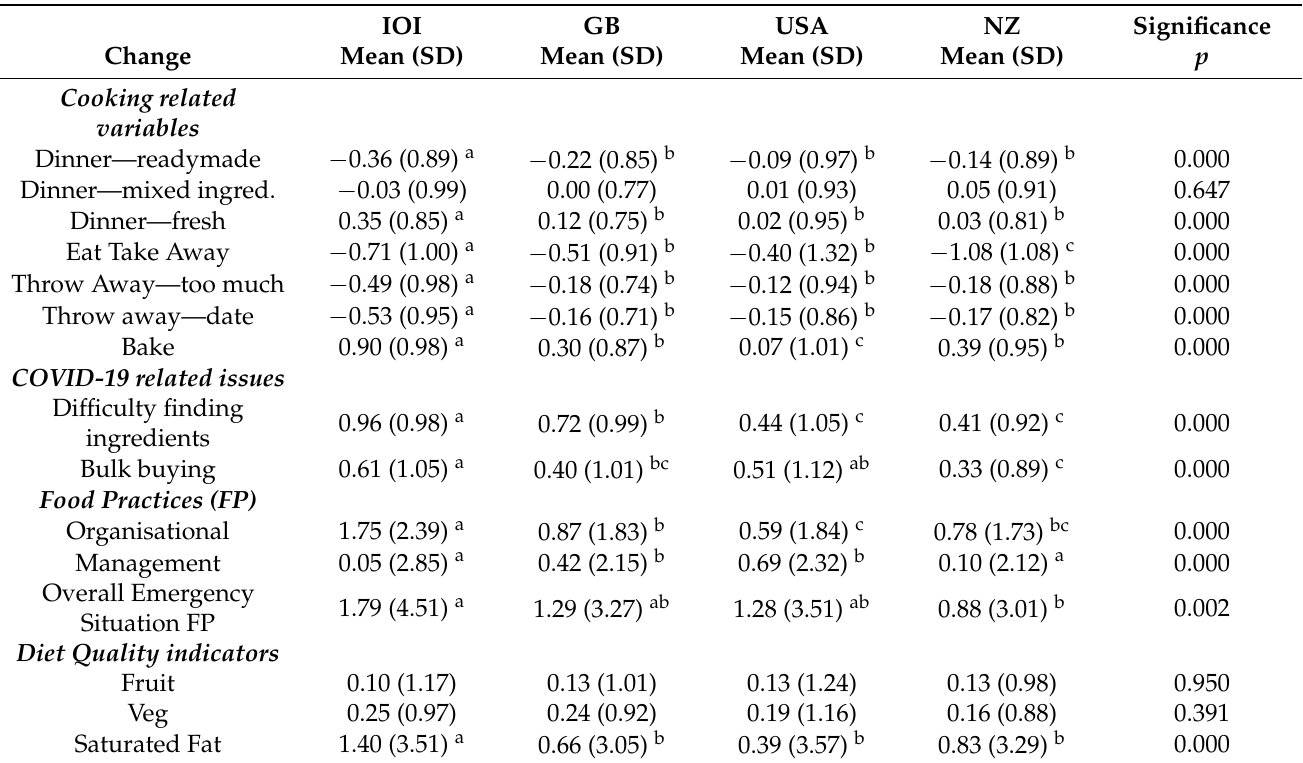
Table 3. Inter region differences on changes in food related variables and Emergency Situation Food Practices. IOI GB USA NZ